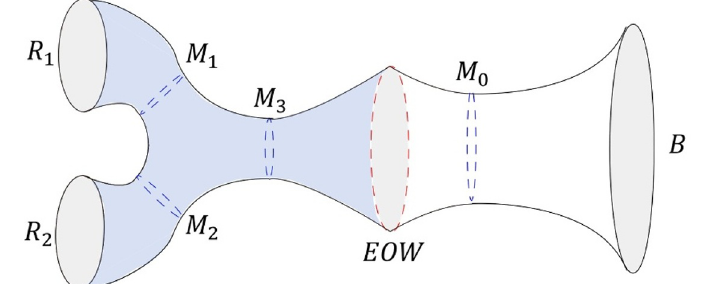
Figure 8 . We purify the black hole in the inception geometry with a two-boundary wormhole. The two asymptotic boundaries R 1 and R 2 are two parts of Hawking